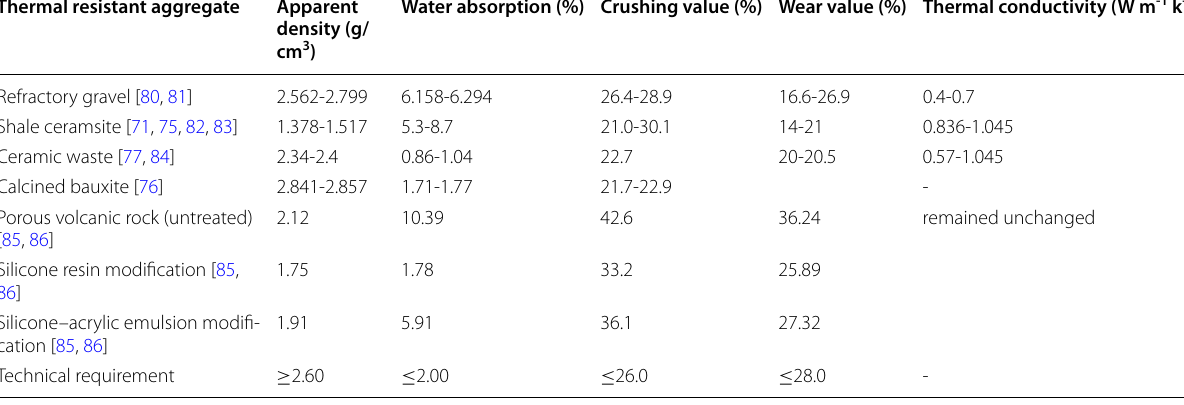
Table 4 Basic properties of thermal resistant aggregate Thermal resistant